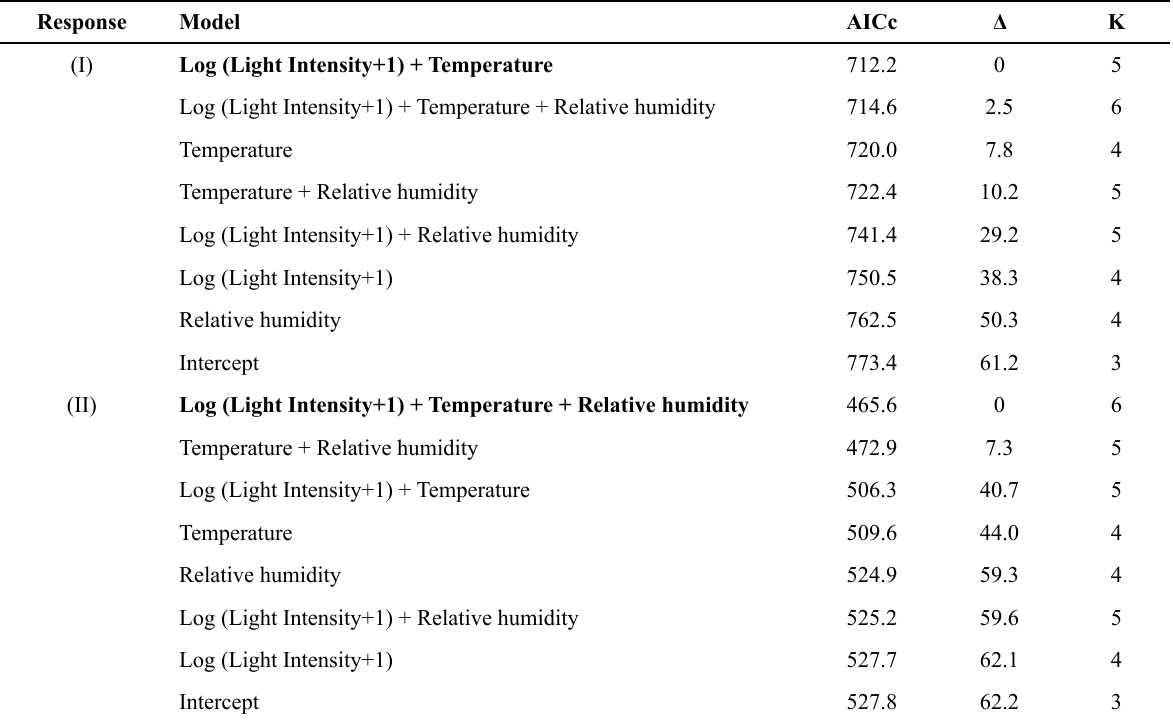
Table 1. Models describing the probability of microclimatic variables that influenced the flower opening (I) and closing (II) processes of Ipomoea bahiensis (Convolvulaceae). Comparisons of the different models with sample size correction (AICc), AICc differences (Δ), number of variables (k). The models are classified in the ascending order of